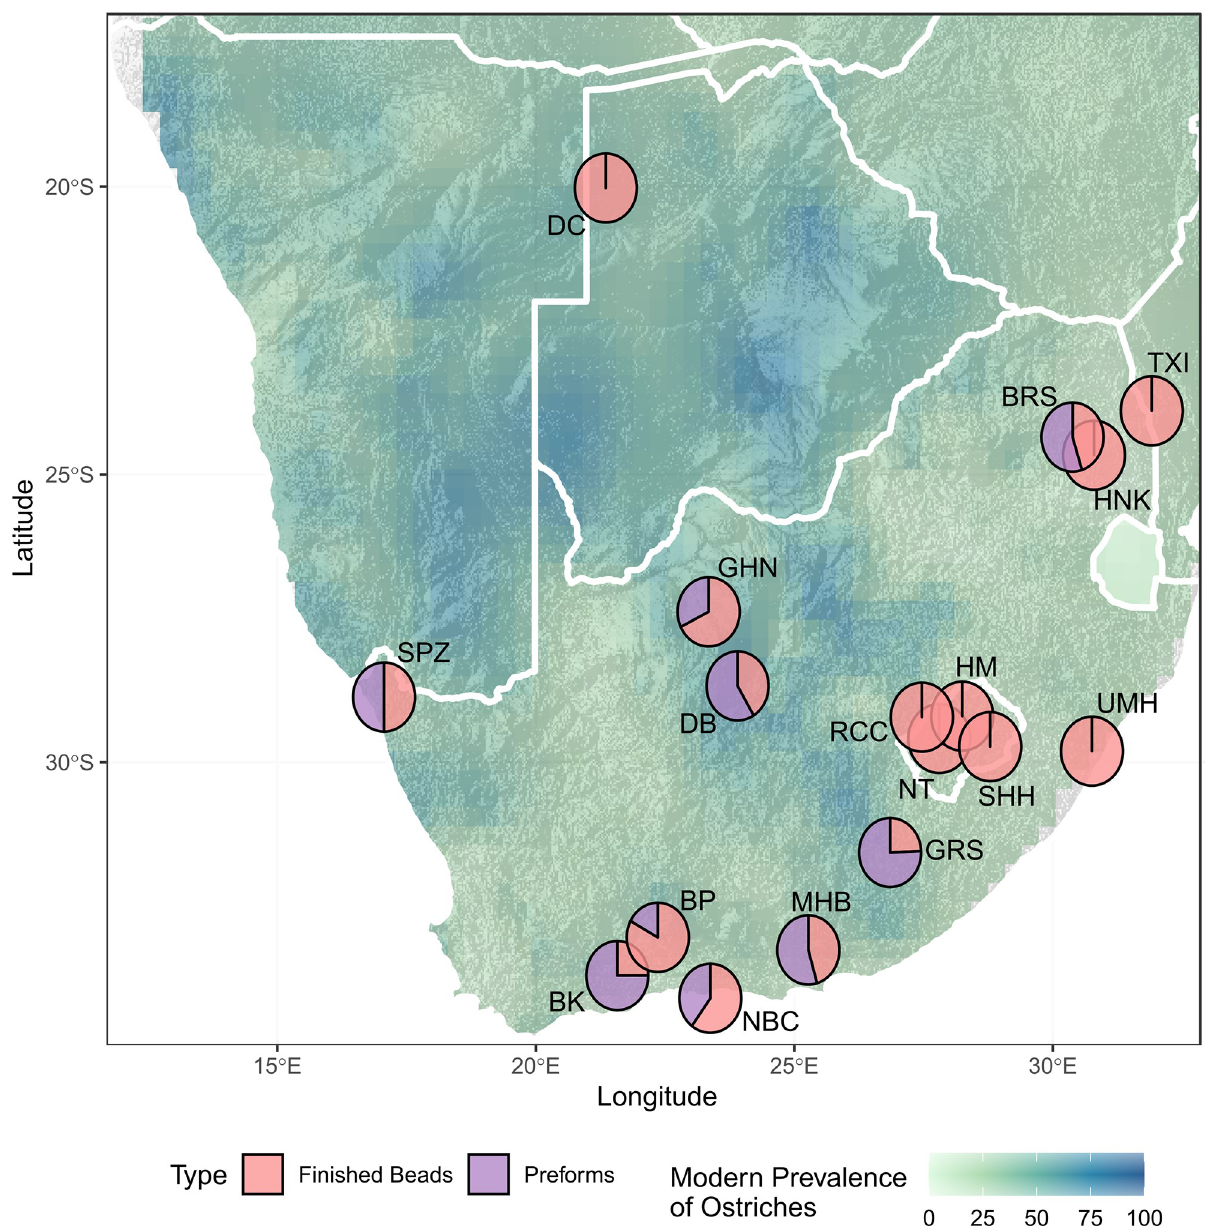
Fig 4. Map of southern Africa showing archaeological sites dated to MIS 2 that have OES bead assemblages. Pie charts show the proportion of preforms to finished beads at each site, overlaid on a map of modern ostrich prevalence based on South African Bird Atlas Project 2 data [60]. SPZ– Spitzkloof A, BP–Boomplaas, BK–Buffelskloof, NBC–Nelson Bay Cave, MHB–Melkhoutboon, GRS—Grassridge Rockshelter, NT–Ntloana Tsoana, RCC–Rose Cottage Cave, SHH–Sehonghong, HM–Ha Makotoko, UMH–Umhlatuzana, BRS–Bushmans Rockshelter, HNK—Heuningneskrans,